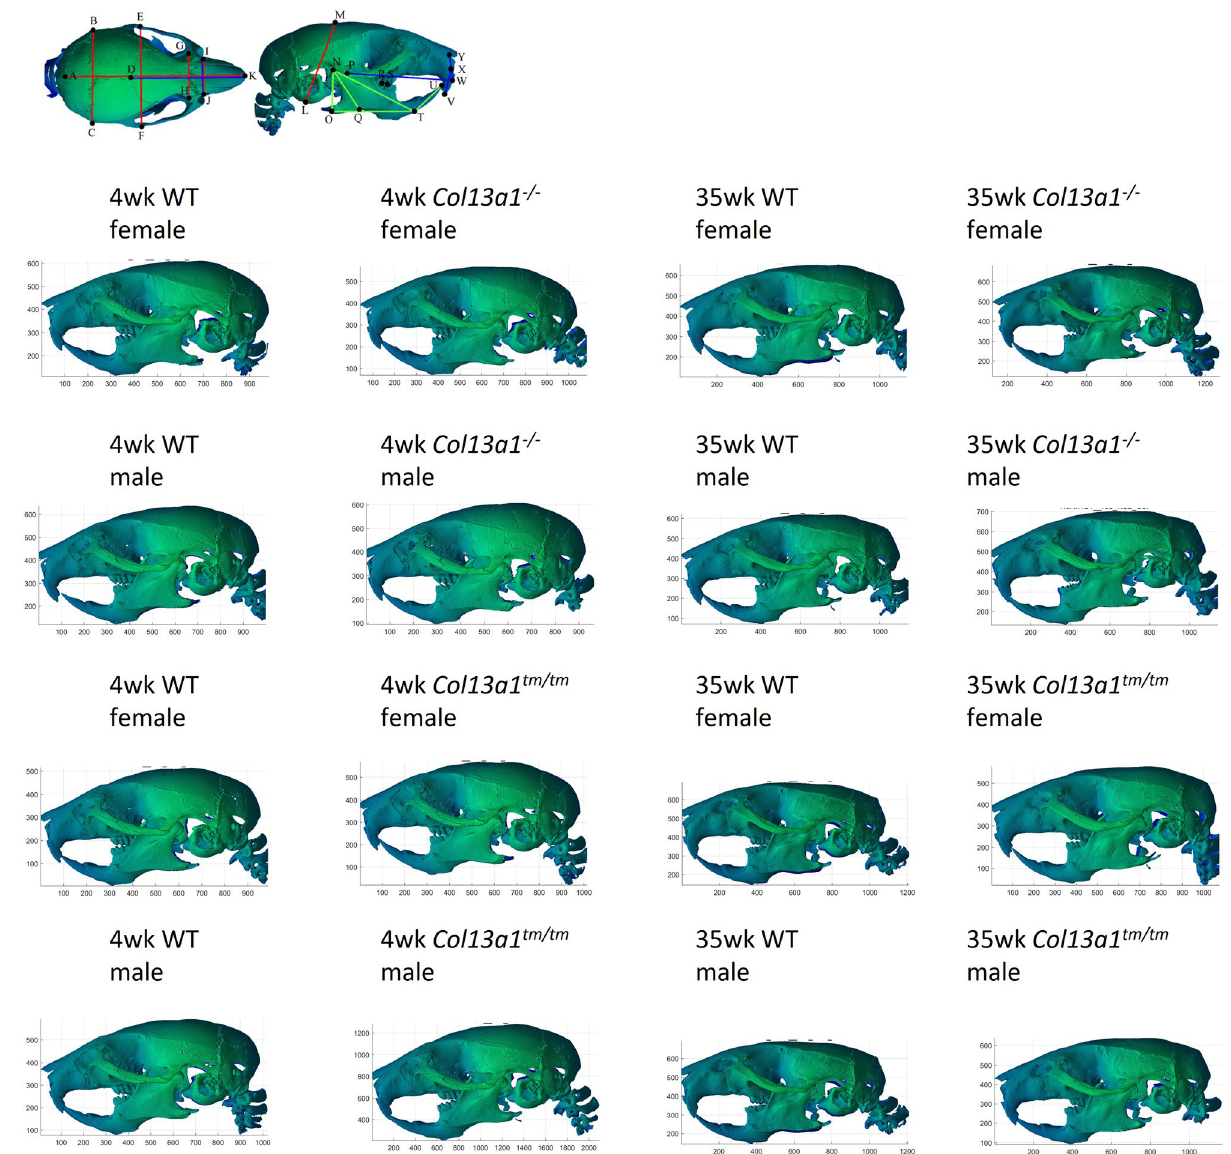
Figure 7. A 3D-reconstructed image of male and female mouse skulls, showing 25 anatomic landmarks used in the cephalometric analysis. Representative images of Col13a1 −/− and Col13a1 tm/tm female mice and respective WT controls at 4- and 35-week time points. For measurement data, see the Supplementary Tables S2 and S2, and Supplementary Figs. S7 and Single axial and sagittal 2D projection images were generated from the 3D-reconstructed image datasets. From these projection images (Fig. 7), the morphometric analysis (Supplementary Table S1 and Supplemen- tary Figs. S3–S5) was conducted according to a previously published method 24 . In the 4-week-old male and female Col13a1 −/− mice, the interzygomatic length, effective mandibular length and ascending ramus length were reduced compared to the respective WT controls (Supplementary Table S2, Supplementary Figs. S7 and S8). Additionally, the internasal distance was reduced in male, and the upper incisor height, mandibular plane and posterior mandibular height were reduced in female Col13a1 −/− mice compared to the respective WT con- trols. In the 35-week-old male Col13a1 −/− mice, no significant differences were found in the parameters altered at the 4-week time point. Instead, the interorbitary length was reduced and the inferior incisor length was slightly increased compared to the respective WT controls. In the 35-week-old female Col13a1 −/− mice, the interzy- gomatic length, mandibular plane and posterior mandibular height were normalized from the 4-week to the 35-week time point, whereas the upper incisor length, mandibular plane and ascending ramus length remained reduced compared to WT (Supplementary Table S2, Supplementary Figs. S9 and S10). In the 4-week-old male Col13a1 tm/tm mice, the upper incisor length and the posterior mandibular height were reduced compared to the WT controls (Supplementary Table S3). At the 35-week time point, the interzygomatic length, palatine length, upper incisor length, inter-molar maxillary distance, ascending ramus length and posterior mandibular height